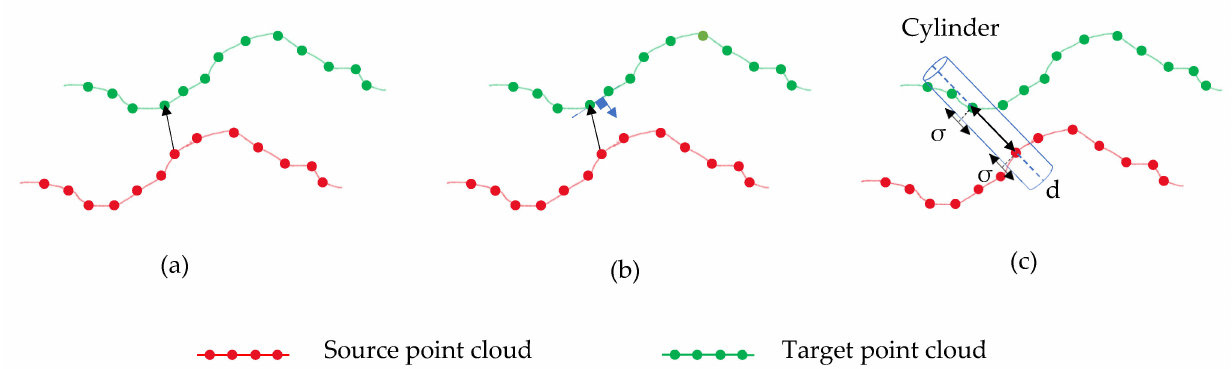
Figure 4. Existing approaches of point-to-point distance calculation. ( a ) Cloud to Cloud. ( b ) Cloud to Mesh. ( c ) Multiscale Model to Model Cloud